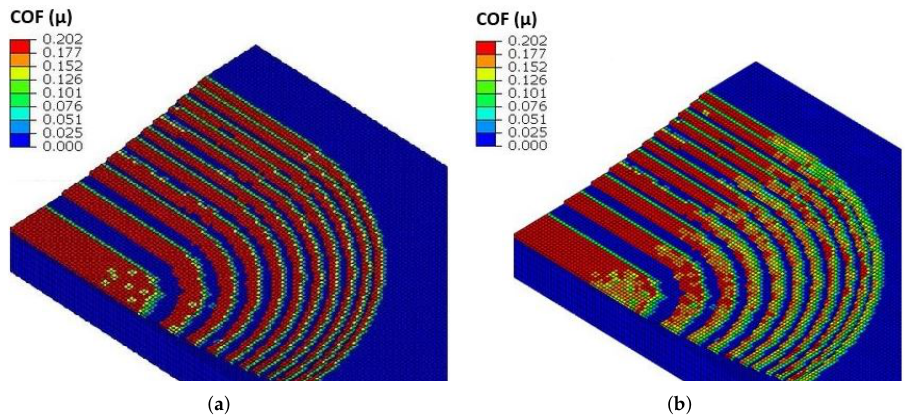
Figure 13. A section of the tribo open-loop FE model with the pin removed—constant ( a ); VFRIC- TION ( b